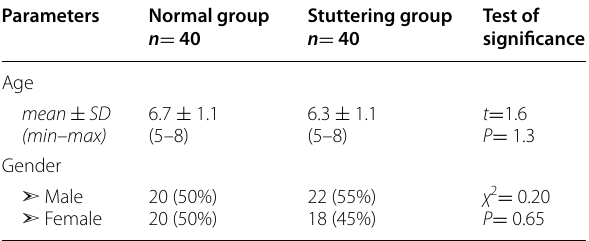
Table 1 Demographic characteristics of the studied groups Parameters